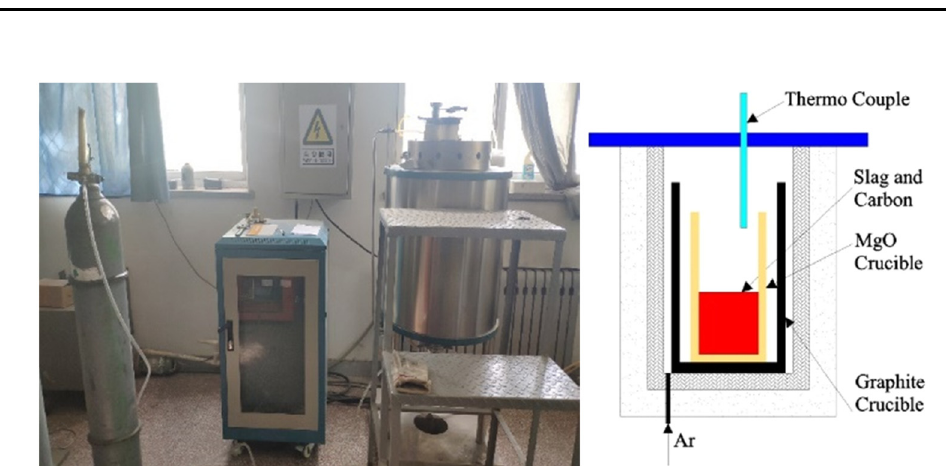
Experimental No.